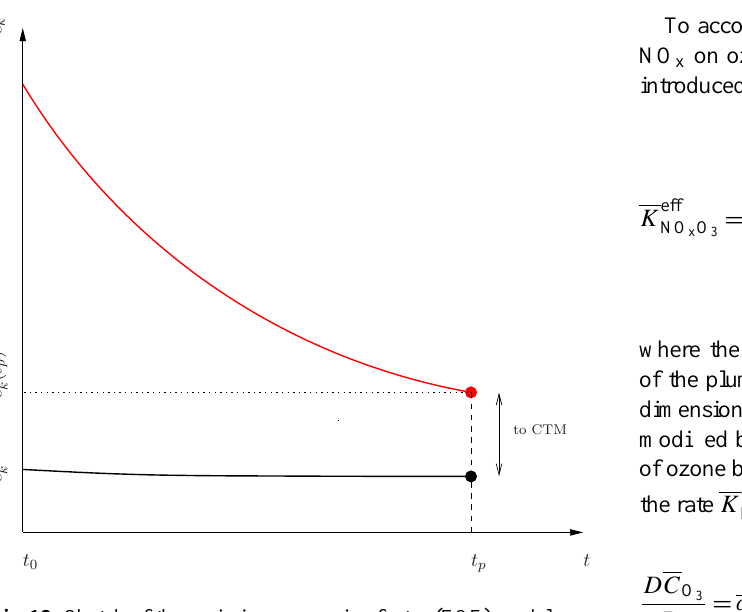
Fig. 12. Sketch of the emission conversion factor (ECF)